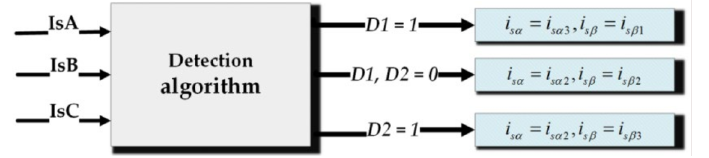
Figure 14. General diagram of current sensor fault compensation algorithm.